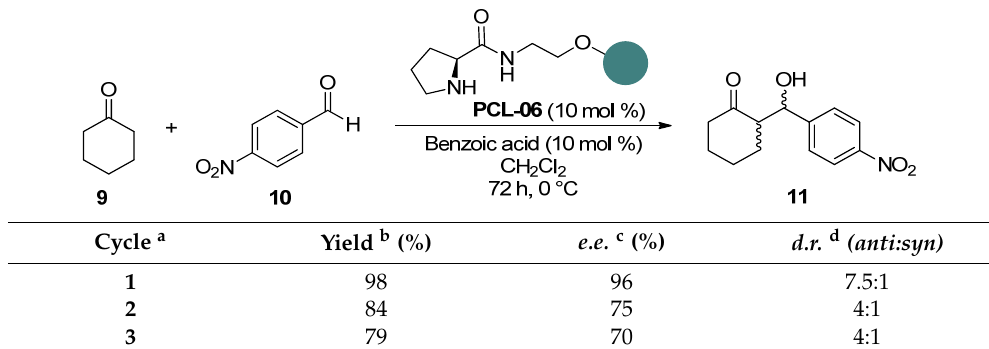
Table 5. Reuse of polymer PCL-06 in asymmetric aldol addition reaction.